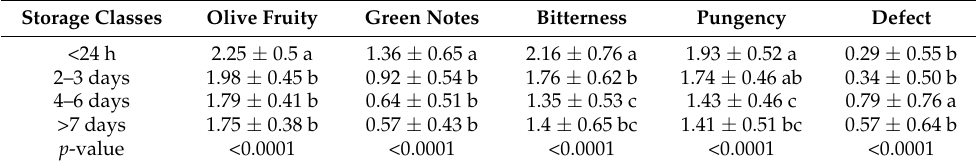
Table 5. The intensity of sensory attributes (aroma of olive fruity and green notes, flavor of bit- terness, pungency and defect) of oil samples related to different olive time storage. Values are median ± standard deviation. Values followed by different letters in the same column (a, b, c) were significantly different according to Tukey’s test ( p <